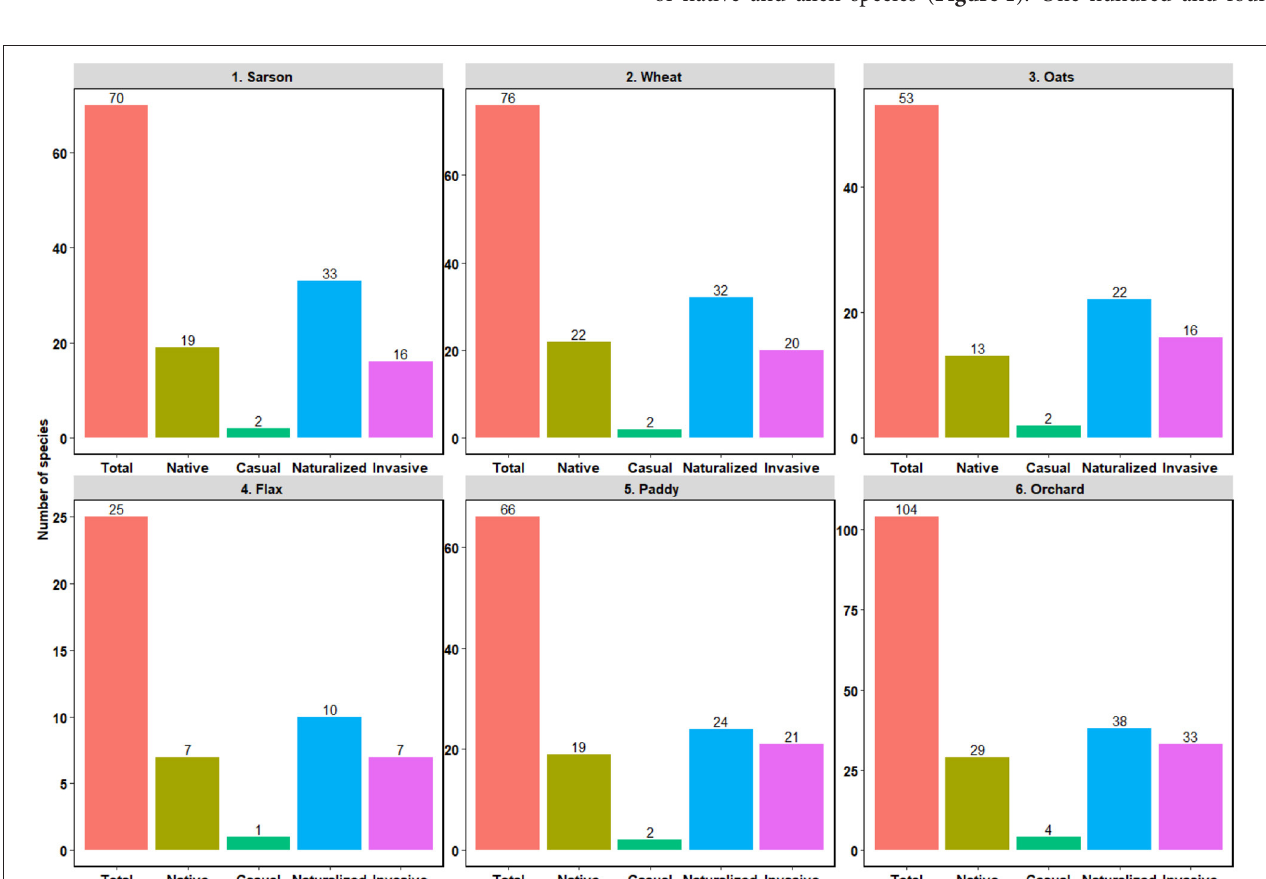
FIGURE 1 | Number of native, casual, naturalized and invasive species in surveyed agroecosystems.